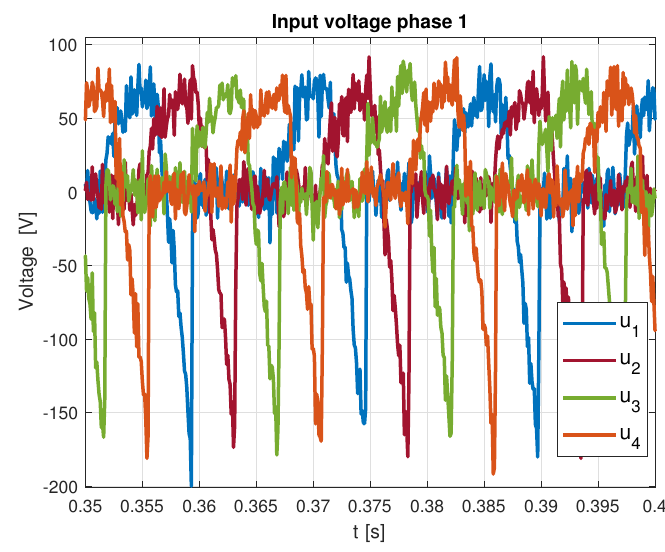
Figure 5. Input signals with added